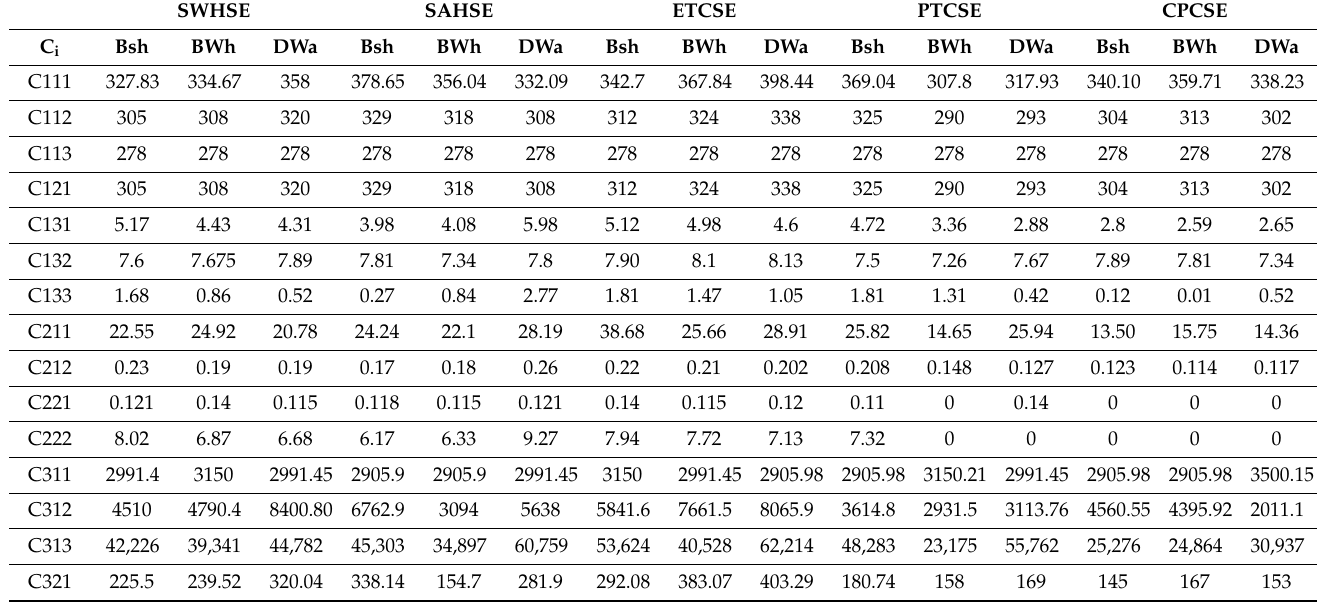
Table 5. Basic attribute values for Niger (Bsh), Riyadh (BWh) and Beijing (DWA) climate zone for single effect